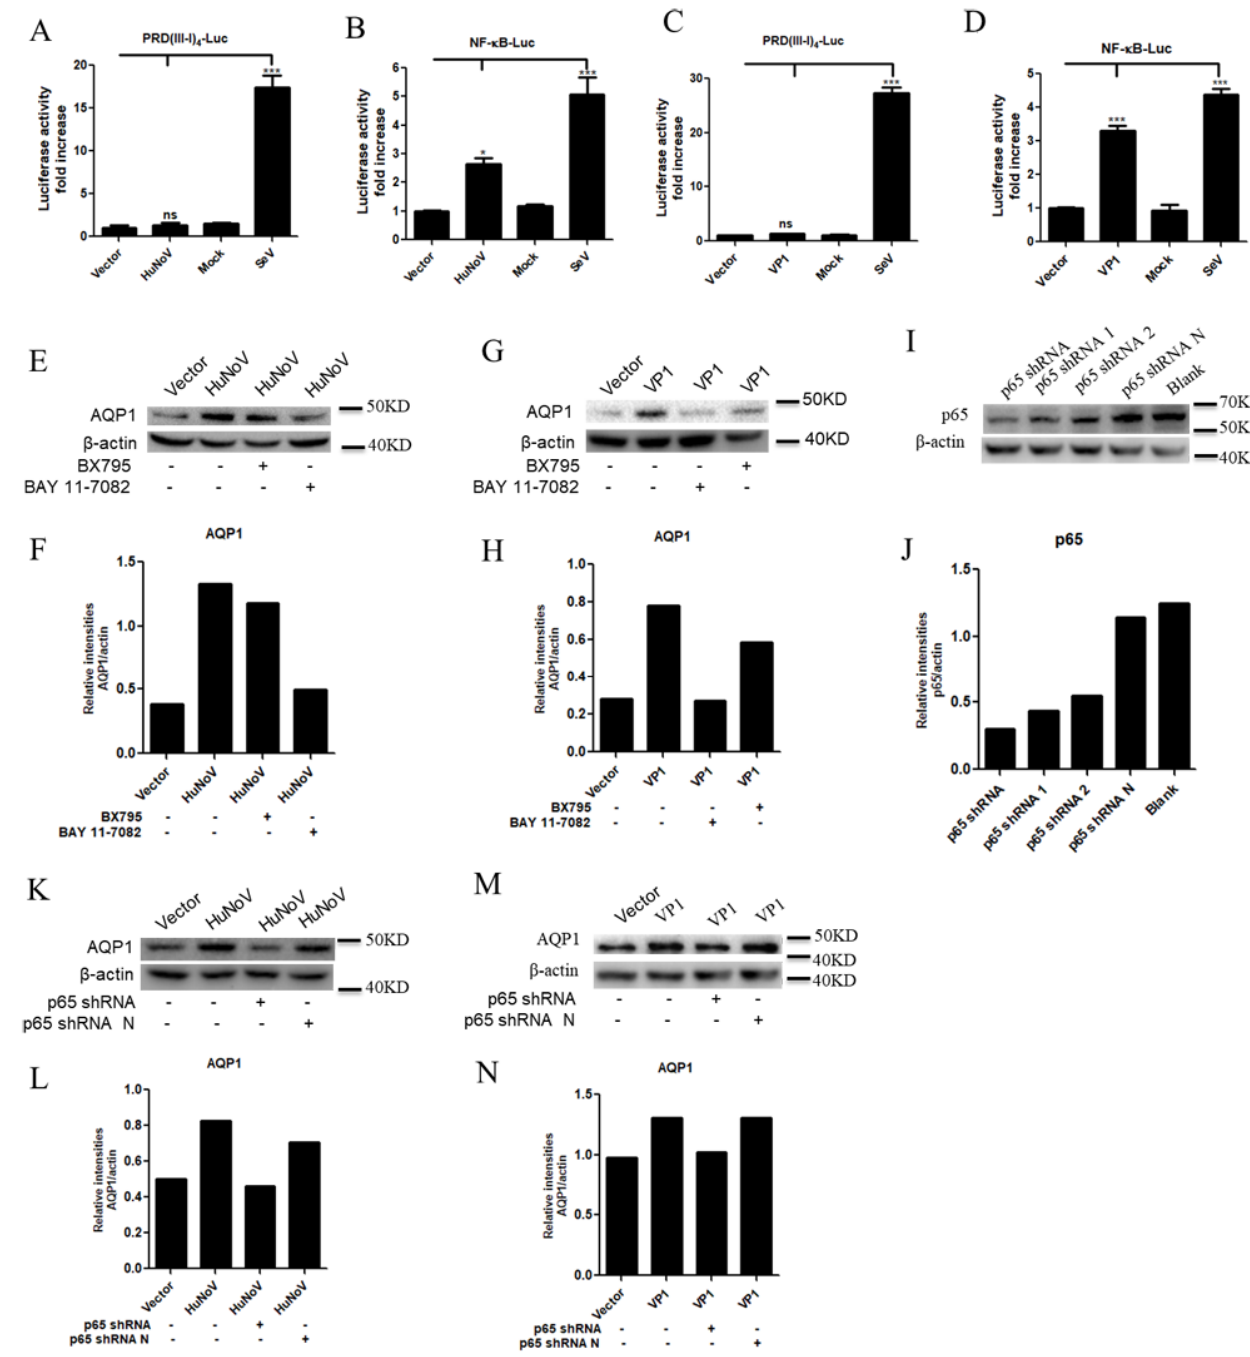
Figure 4. HuNoV promotes AQP1 expression through NF-κB signaling pathway. ( A , B ). HuNoV promoted the activation of NF-κB-responsive promoter. ( C , D ). VP1 promoted the activation of NF-κB-responsive promoter. Caco2 cells were transfected with PRD(III-I) 4 -Luc or NF-κB-Luc for 4 h followed by stimulation with or without 100 HAU mL −1 SeV, or co-transfected with empty vec- tor, full-length HuNoV cDNA ( A , B ) or VP1 ( C , D )-expressing plasmid and PRD(III-I) 4 -Luc or NF-κB-Luc. ( E – H ). HuNoV and VP1 promoted the expression of AQP1 through NF-κB signaling pathway. Caco2 cells were transfected with empty vector or full-length HuNoV cDNA ( E ) or VP1 ( G )-expressing plasmid. The inhibitor BX795 or BAY 11-7082 were added at 4 h post-transfection. At 24 h post-transfection, the expression of AQP1 was detected by WB ( E , G ) and quantified using Image J ( F , H ). ( I – N ). p65 knockdown blocked HuNoV or VP1-induced AQP1 expression. Caco2 cells were transfected with or without different p65 specific shRNA or control shRNA (p65 shRNA N) ( I , J ). The knockdown effect of p65 shRNA was detected by WB ( I ) and quantified using Image J